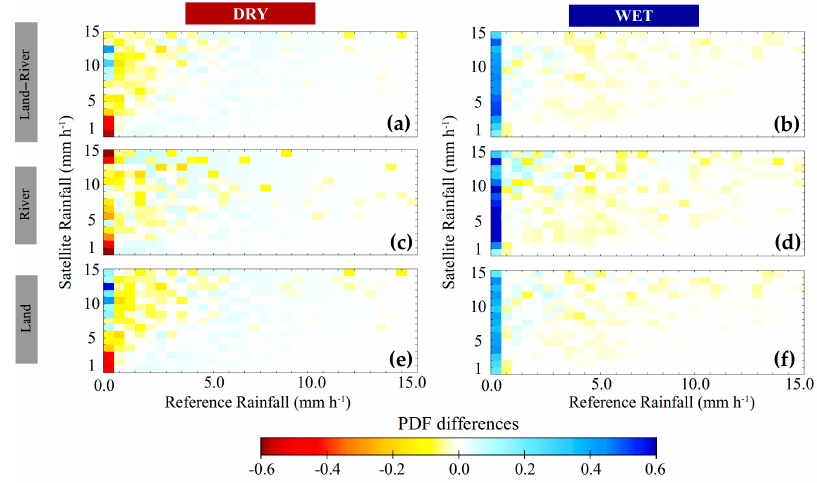
Figure 4. Frequency differences (estimated–observed) (Case 1) for the dry ( left ) and wet ( right ) validation periods and over land–river ( a,b ), river only ( c,d ), and land only ( e,f ), for threshold values of satellite rain rates between 1.0 and 15.0 mm · h − 1